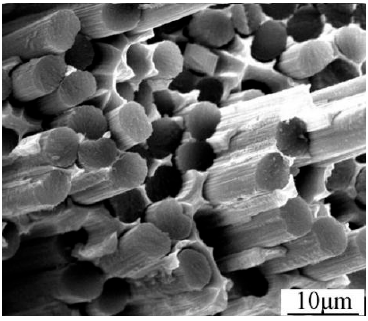
Figure 12. Fracture morphology of the composites subjected to longitudinal tensile loading.